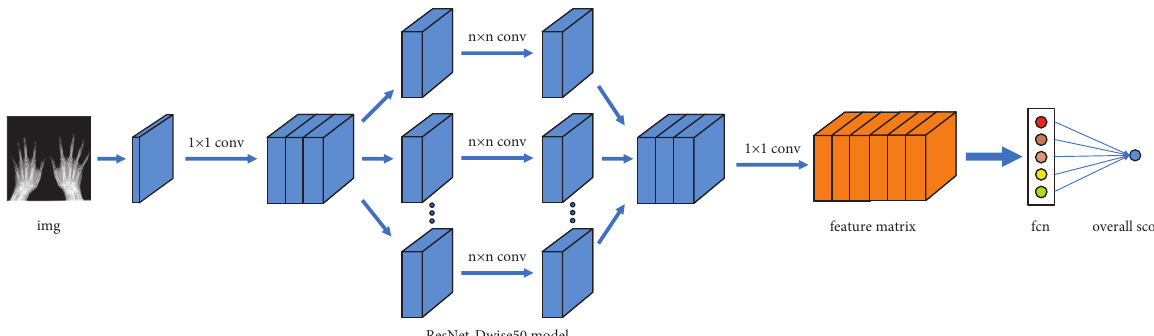
Figure 3: Pipeline of the overall scoring of RA. An inverted residual block with depthwise separable convolution is used to form the ResNet- Dwise50 model to extract the feature matrix followed by a fully connected layer to predict the overall score.